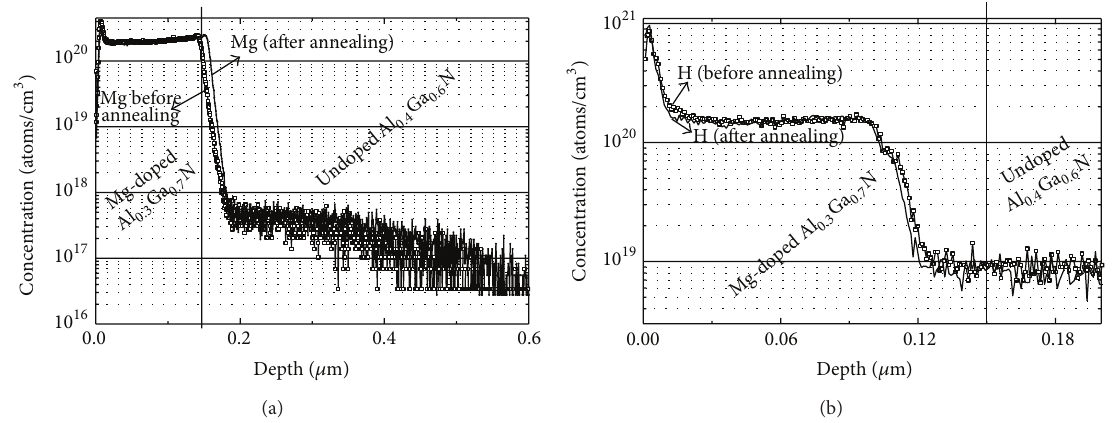
Figure 4: (a) Mg and (b) H SIMS depth profiles before and after 850 ∘ C annealing in N 2